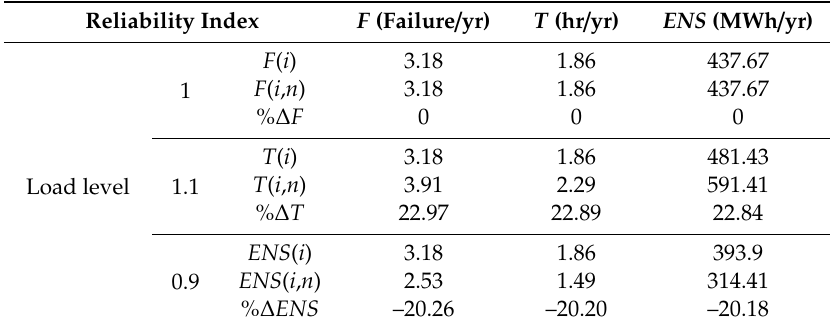
Table 2. Comparison of existing and proposed reliability indices without distributed resources (DRs) before network reconfiguration (NR).